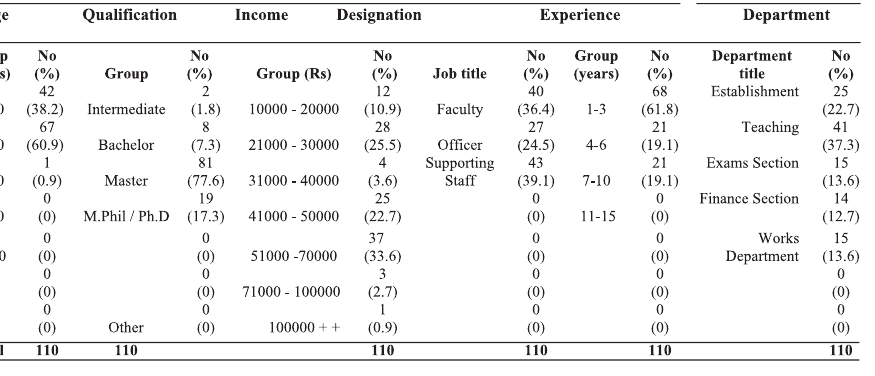
Table 3 expresses the division of respondents on the basis of Gender and Marital